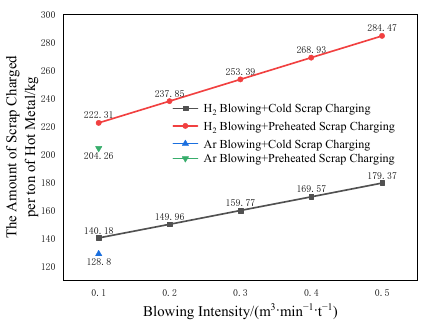
Figure 3. Influence of hydrogen injection intensity and scrap preheating on the charging amount of scrap .